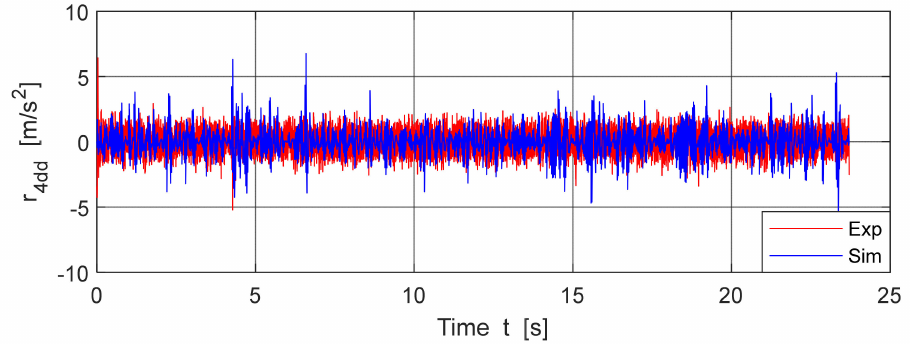
Figure 20. Acceleration on right front axle, V = 15.18